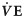
Borg dyspnea ratings as a function of work rate (WR) (panel A) and minute ventilation (V˙E) (panel B) in CTEPH patients showing maximal inspiratory pressure (MIP) < or ≥ 70% predicted according to Neder et al.’s reference equations (closed and open symbols, respectively). Panel C and D shows tidal volume (VT) /inspiratory time (TI) ratio–a crude index of neural drive–and respiratory frequency (f) as a function of V˙E (*p < 0.05).